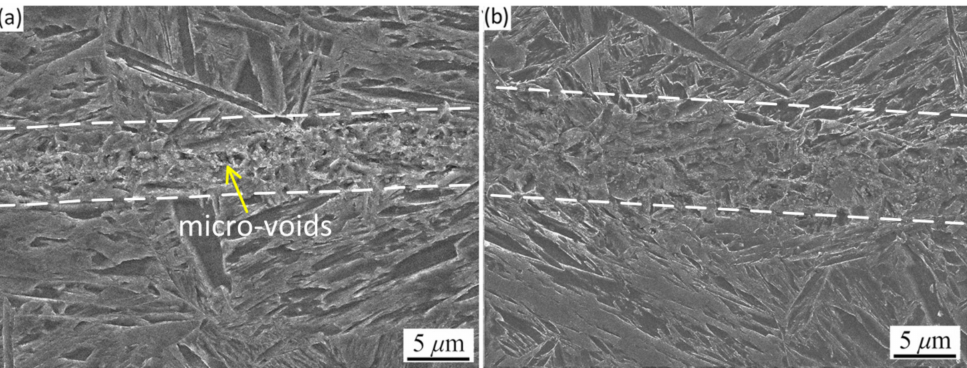
Figure 11. SEM micrographs of crack healing zone under 10% reduction ratio at 1000 ◦ C with different strain rates: ( a ) 1 s − 1 ; and ( b ) 0.01 s − 1 .